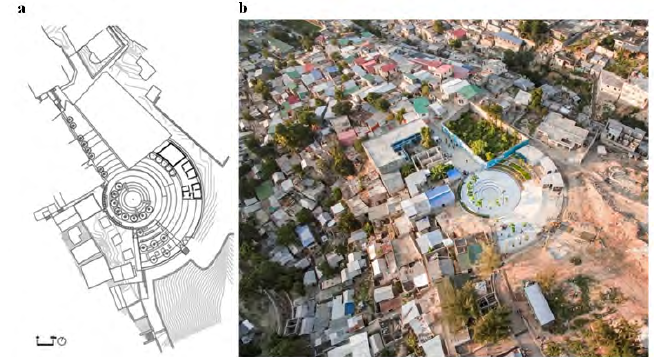
Figure 3. (a) General layout of the project. Source: Wilkinson, T., 2017. (b) Ariel view of the project and the urban context. Source: EVA studio, http://www.evastudio.co.uk/tapis-rouge/